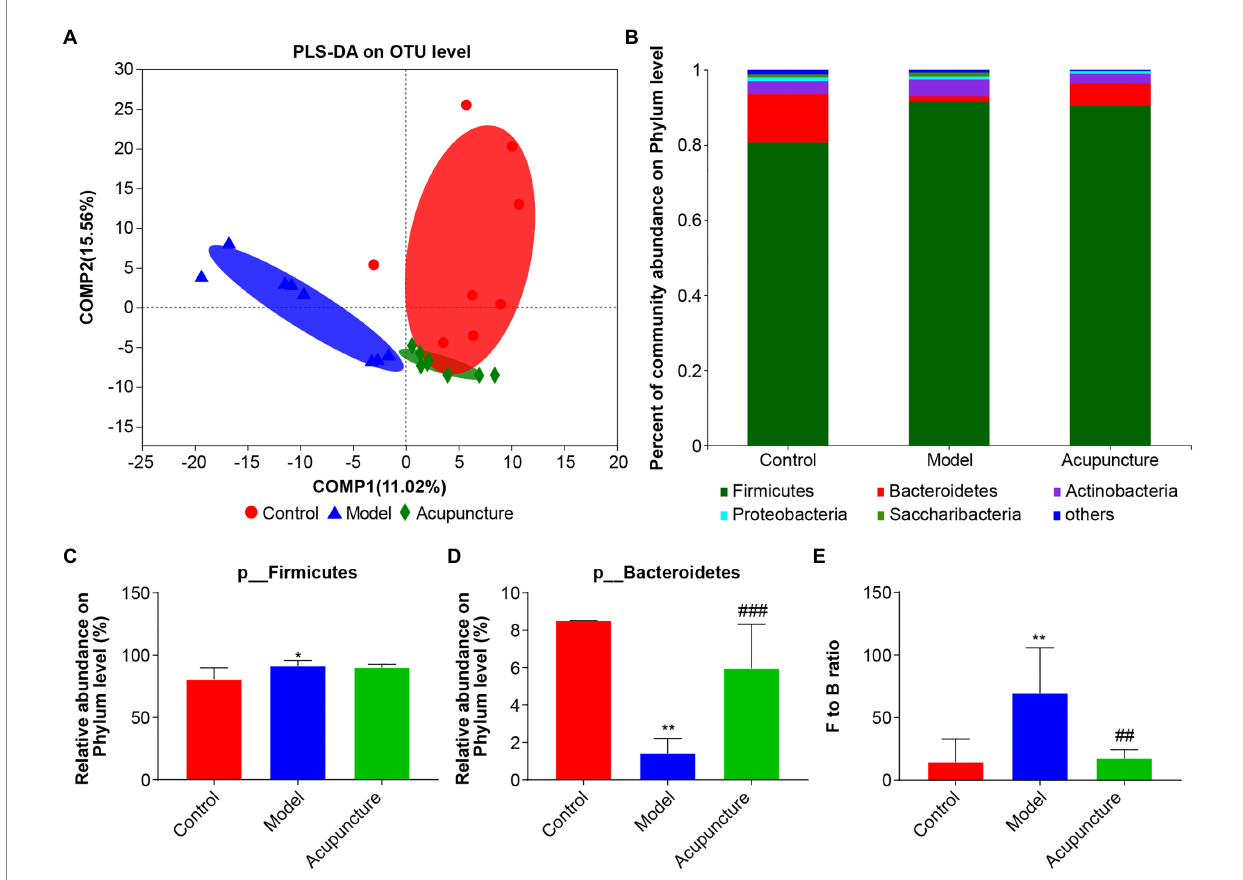
FIGURE 5 Regulating composition of the intestinal microbiota of non-alcoholic fatty liver disease (NAFLD) rats. (A) Partial least squares discriminant analysis (PLS- DA) at the OTU level. (B) Community bar plot analysis at the phylum level. “Others” represents a combination of all species with less than 0.01 abundance among all the samples. (C) Statistical difference analysis of Firmicutes among the control, model, and acupuncture groups. (D) Statistical difference analysis of Bacteroidetes among the three groups. (E) Statistical difference analysis of Firmicutes to Bacteroidetes (F/B) ratio. Data are shown as mean ± SD ( n = 8 per group). * p < 0.05, ** p < 0.01, Control vs. Model; ## p < 0.01, ### p < 0.001, Model vs.